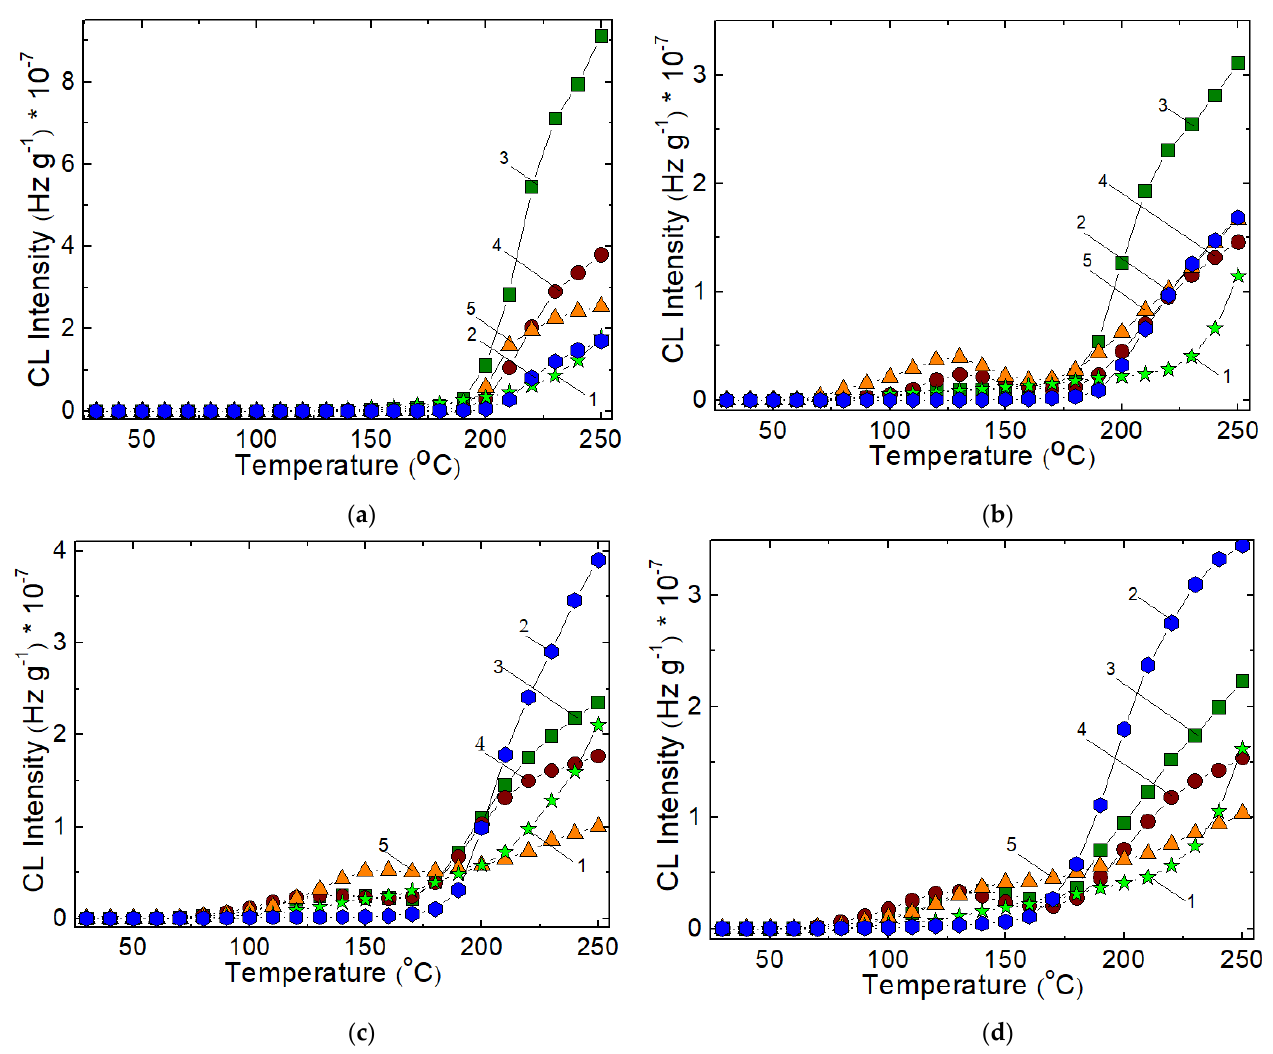
Figure 4. Nonisothermal CL spectra recorded on the samples consisting of SIS and PCL exposed to γ -rays at various doses: ( a ) 0 kGy, ( b ) 25 kGy, ( c ) 50 kGy, ( d ) 100 kGy; (1) neat PCL, (2) neat SIS,(3) PCL:SIS = 3:1, (4) PCL:SIS = 1:1, (5) PCL:SIS = 1:3. Heating rate: 10 °C min −1 .